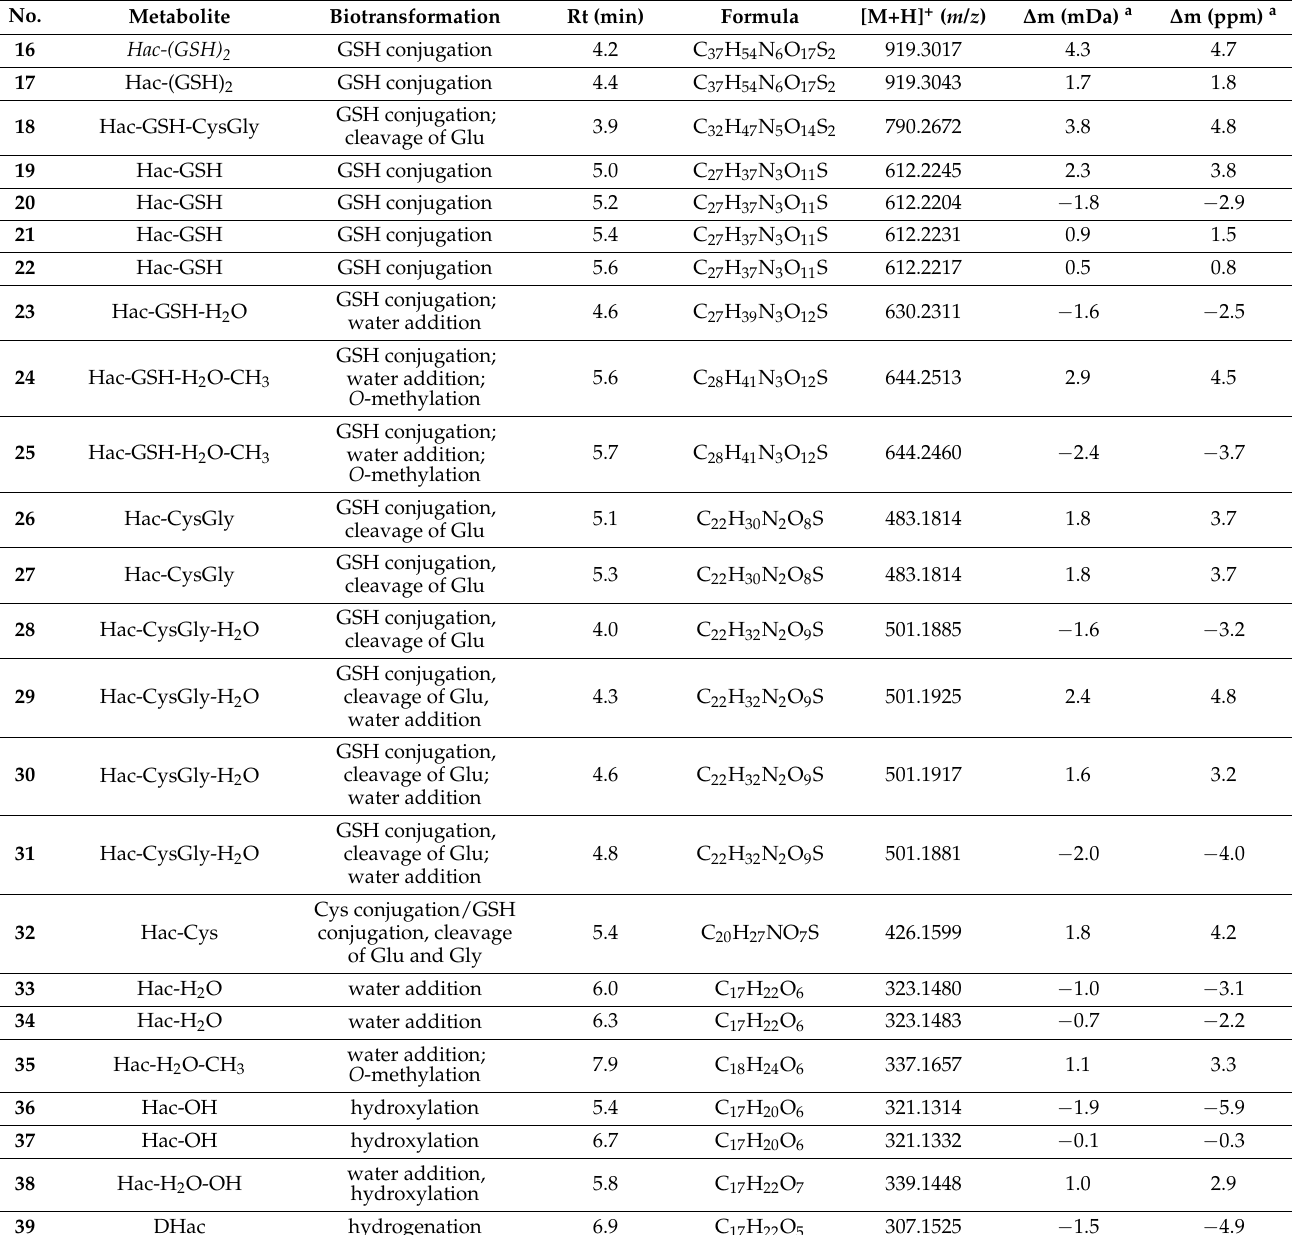
Table 2. Suggested biotransformation of Hac based on phase I and phase II metabolism experi- ments. Metabolites detected by UHPLC-(+ESI)-QqTOF MS are grouped by similar biotransformation reactions and characterized by their retention time (Rt), elemental formula, measured protonated molecule [M+H] + and mass deviations ( ∆ m—measured/calculated